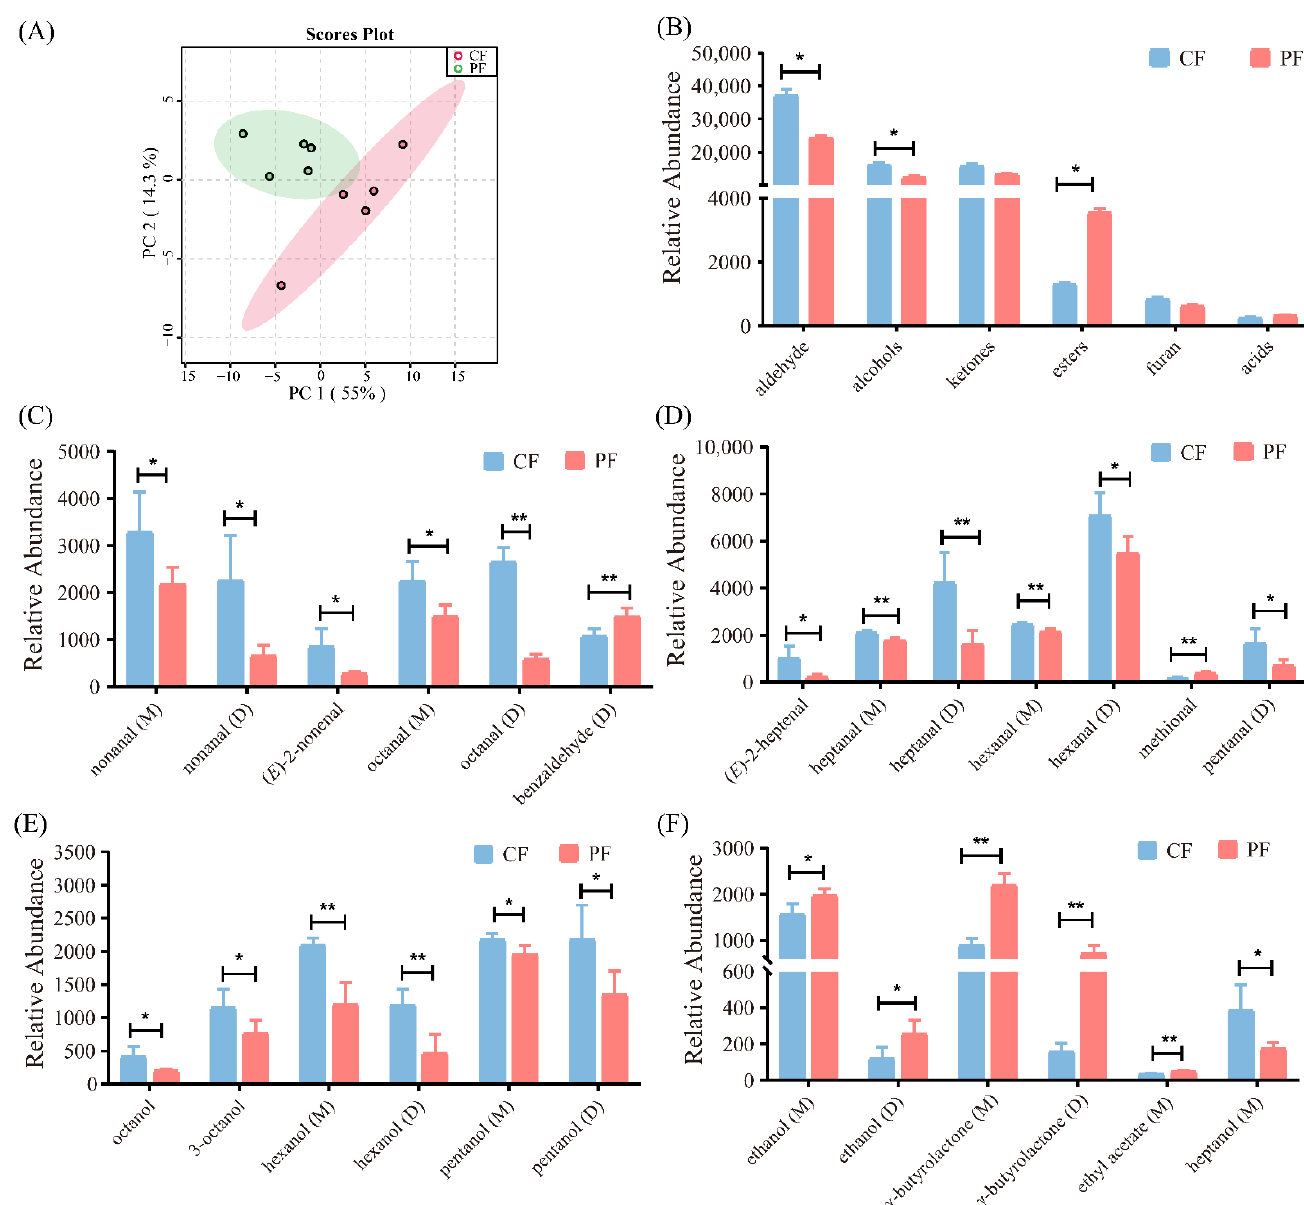
Figure 5. Comparison of the identified volatile compounds in concentrate-fed (CF) and pasture-fed (PF) groups ( n = 5). ( A ) Principal component analysis score plots of volatile compounds in lamb with different feeding systems. ( B ) Comparison of volatile categories identified in the CF and PF groups. ( C – F ) Bar graphs present the significant volatile compounds between the CF and PF groups. M, monomer; D, dimer. * p < 0.05, ** p < 0.01.